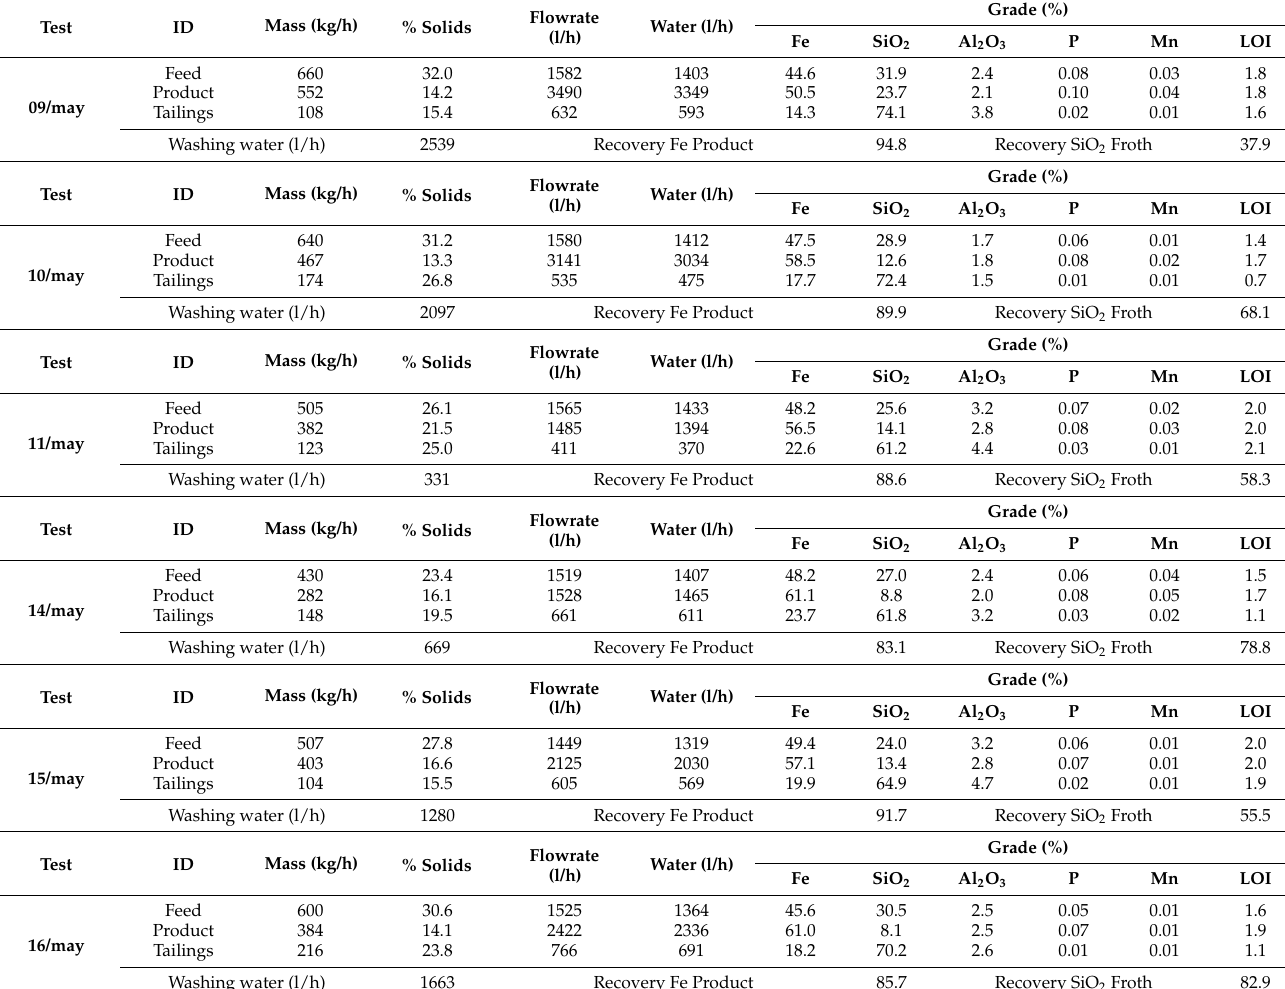
Table 5. Results of the pilot tests from 9 to 16 May 2018.